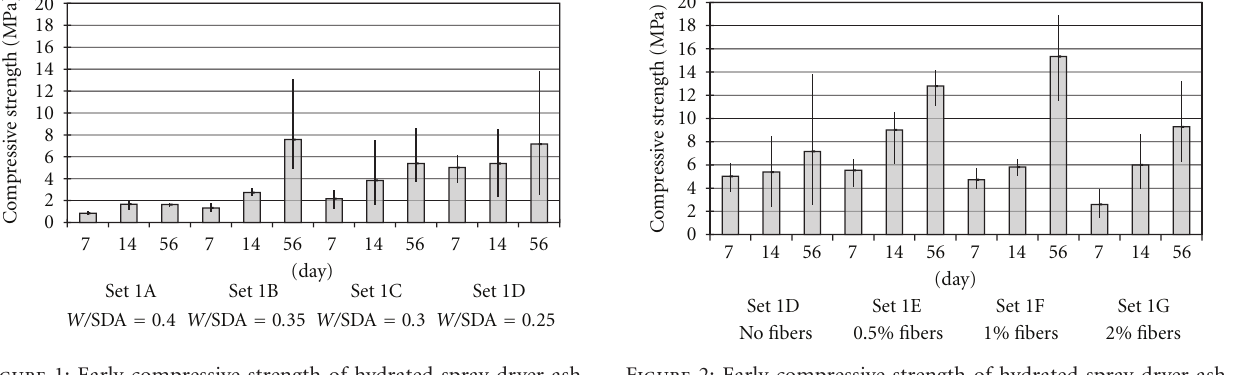
Figure 1: Early compressive strength of hydrated spray dryer ash pastes.